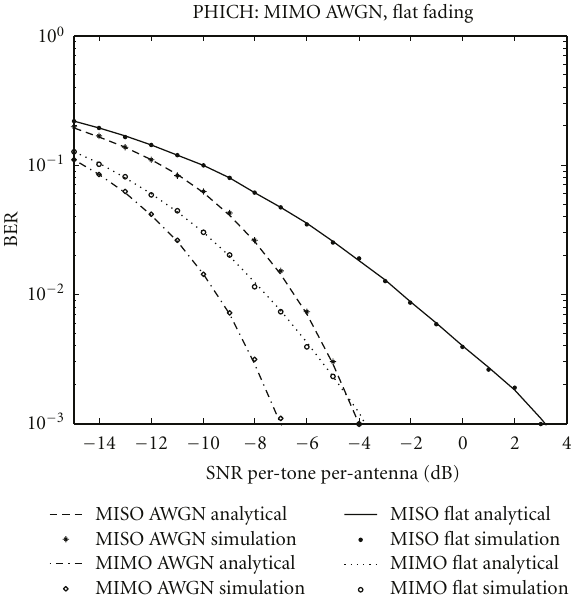
Figure 6: PHICH performance in MIMO